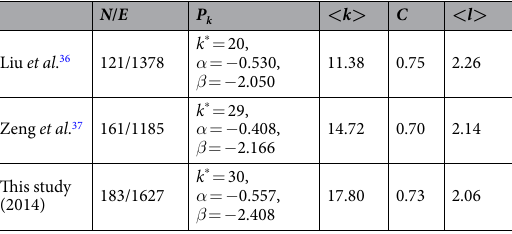
Table 1. Comparison of topological characteristics of static